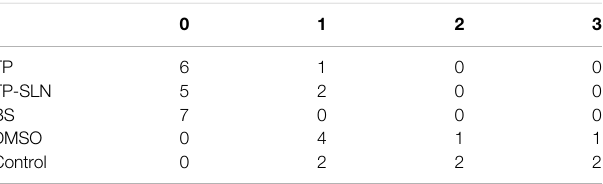
TABLE 2| The results ofultrasonic evaluation ofsynovium blood fl ow ofknee joint in the fi fth week.